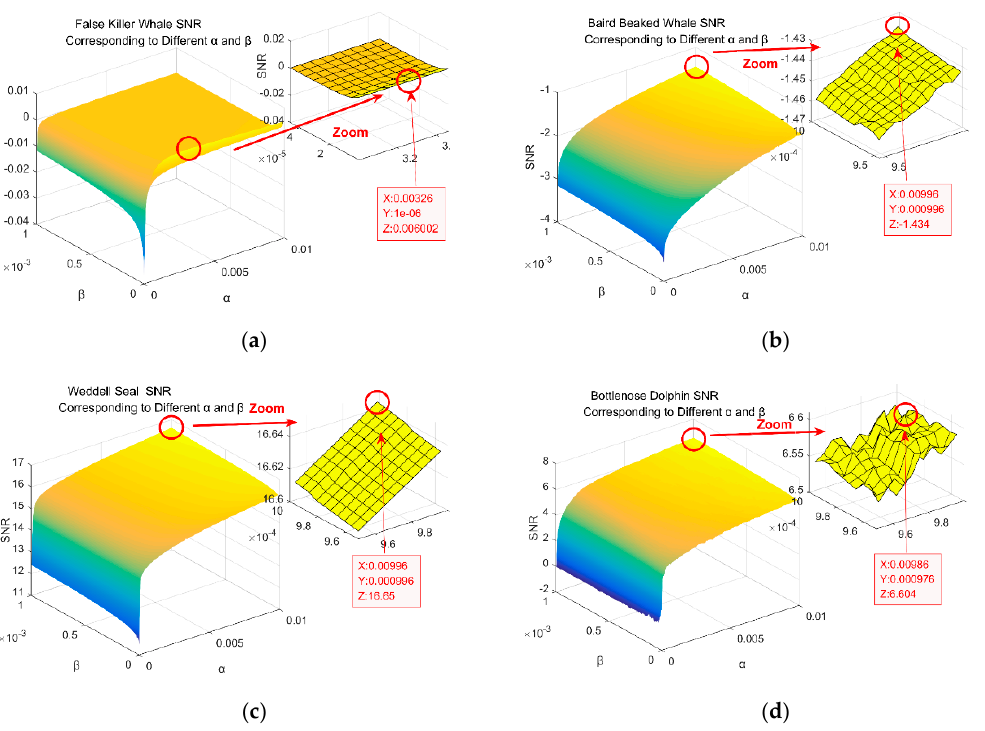
α Figure 9. The most suitable and β for four kinds of animals (( a ). False Killer Whale's locally Figure 9. The most suitable α and β for four kinds of animals (( a ). False Killer Whale’s locally enlarge enlarge around maximum point of SNR;( b ). Baird’s Beaked Whale's locally enlarge around around maximum point of SNR; ( b ). Baird’s Beaked Whale’s locally enlarge around maximum point maximum point of SNR;( c ) Weddell Seal's locally enlarge around maximum point of SNR;( d ) of SNR; ( c ) Weddell Seal’s locally enlarge around maximum point of SNR; ( d ) Bottlenose Dolphin’s Bottlenose Dolphin's locally enlarge around maximum point of SNR). locally enlarge around maximum point of